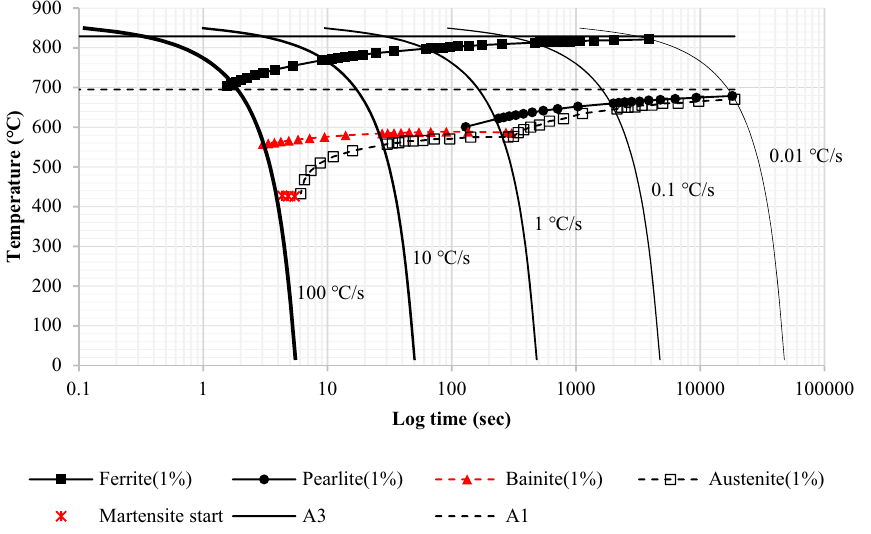
Figure 8. CCT diagram of Nb-V-Al micro-alloyed low carbon steels